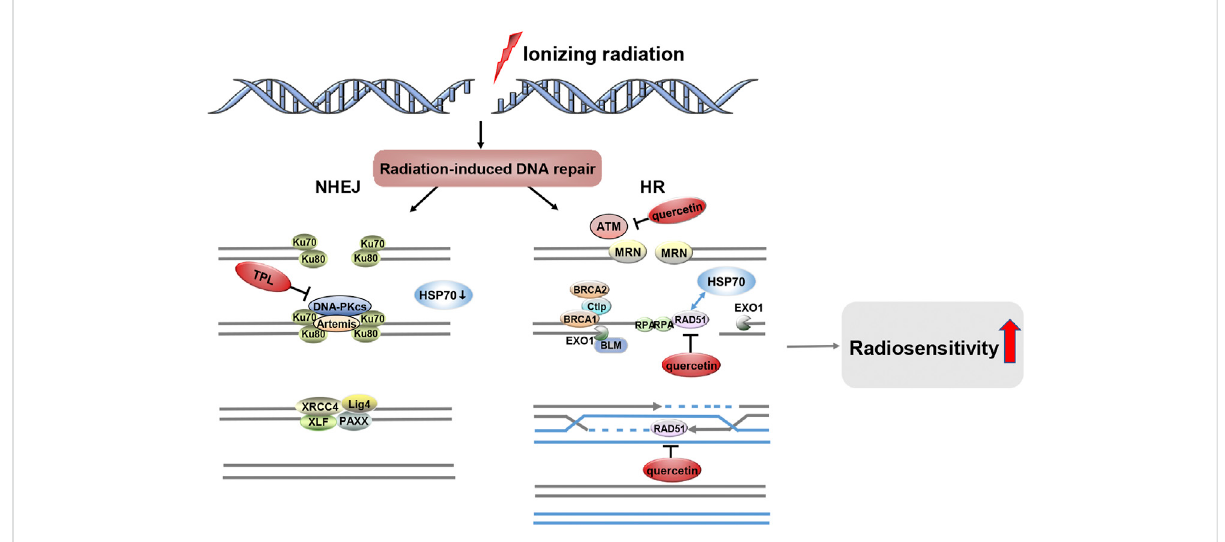
FIGURE 3 HSP70 Inhibitors Inhibit the Repair of Radiation-induced DNA Damage. After ionizing radiation-induced DSBs, two distinct DNA repair systems emerged, namely NHEJ and HR. HSP70 inhibitors such as quercetin and TPL can be involved in the DNA damage repair pathway, and they increase the radiosensitivity of tumors by inhibiting radiation-induced DNA damage repair.